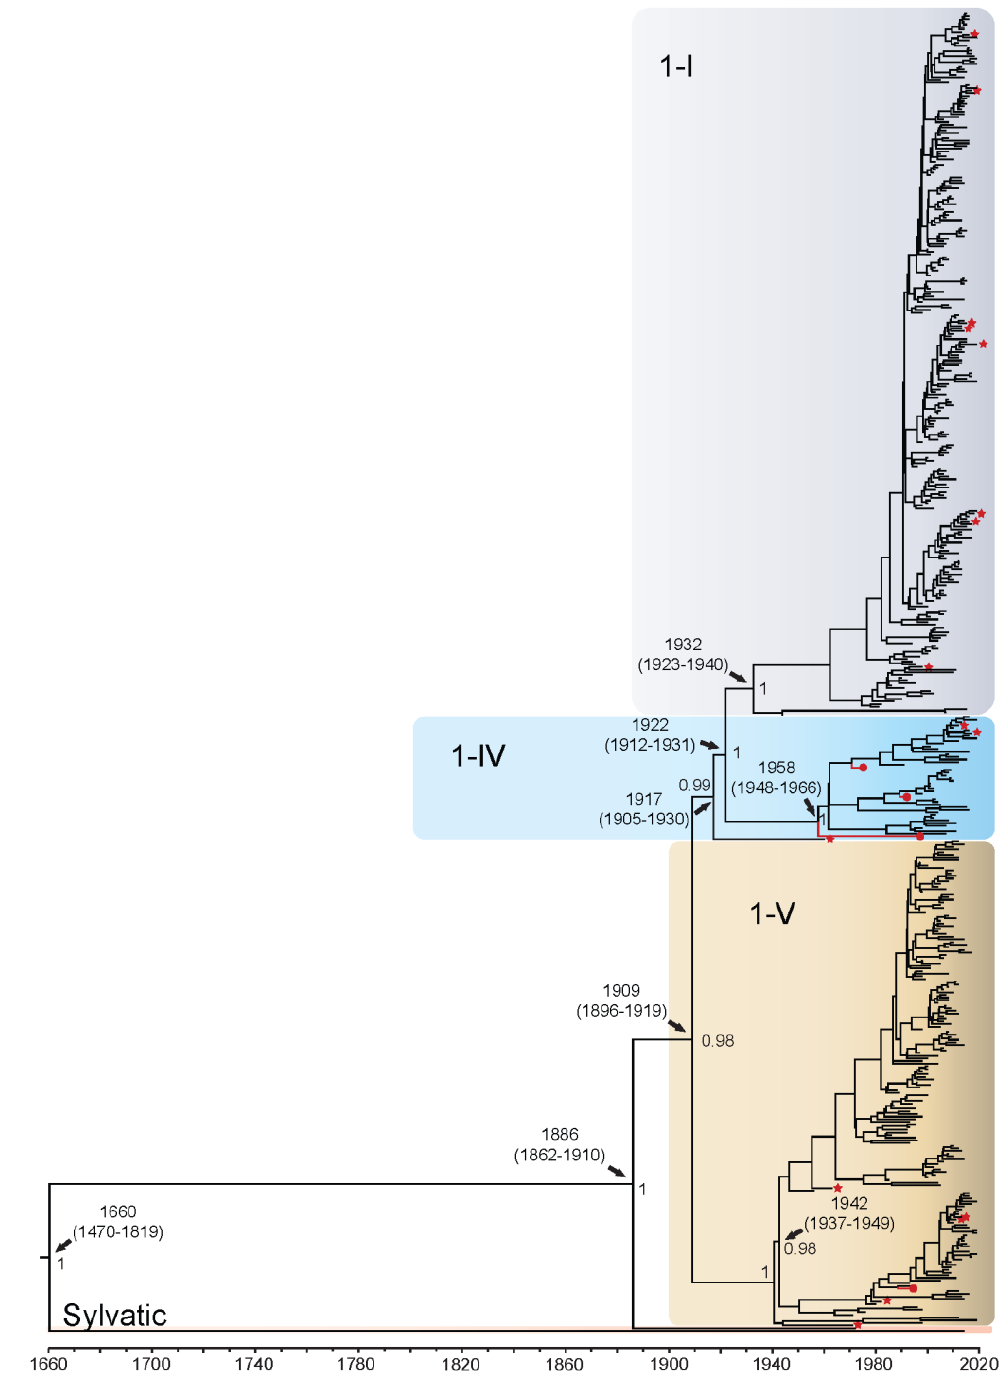
Figure 1. Bayesian phylogenetic tree from analysis of DENV1 whole genome complete coding sequences. Scale axis is representative of calendar years. Posterior node support is indicated for the major branches, with values <0.8 eliminated in most instances for clarity. Red circles indicate newly sequenced isolates from the QUT Arbovirus collection. Branches under positive selection (see Section 3.2.2) are indicated by red stars.